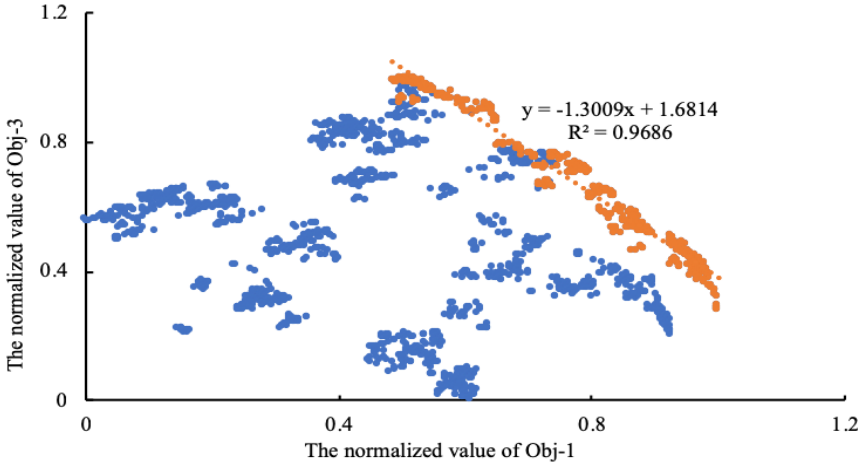
Figure 8. The two-dimensional scatter plots of Obj-1 and Obj-3’s normalized value. All the points indicate Pareto set, and among them, the orange points represent the Pareto